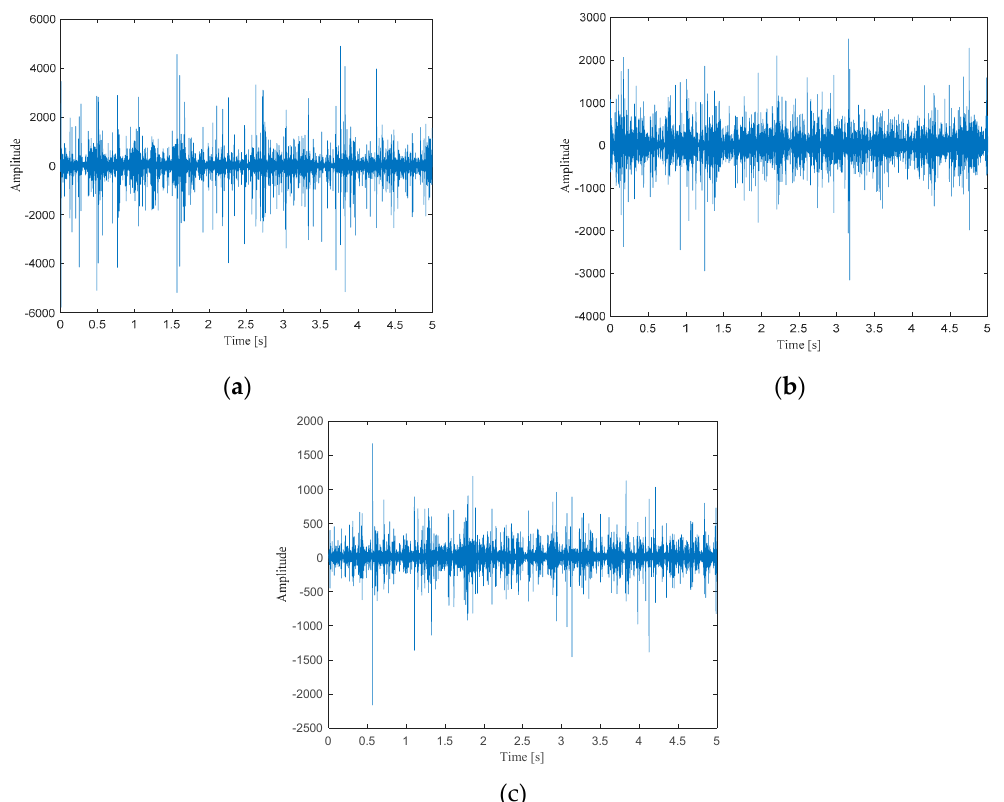
Figure 8. Waveforms of the original cylinder vibration signals: ( a ) working condition 1; ( b ) working condition 2; ( c ) working condition 3.